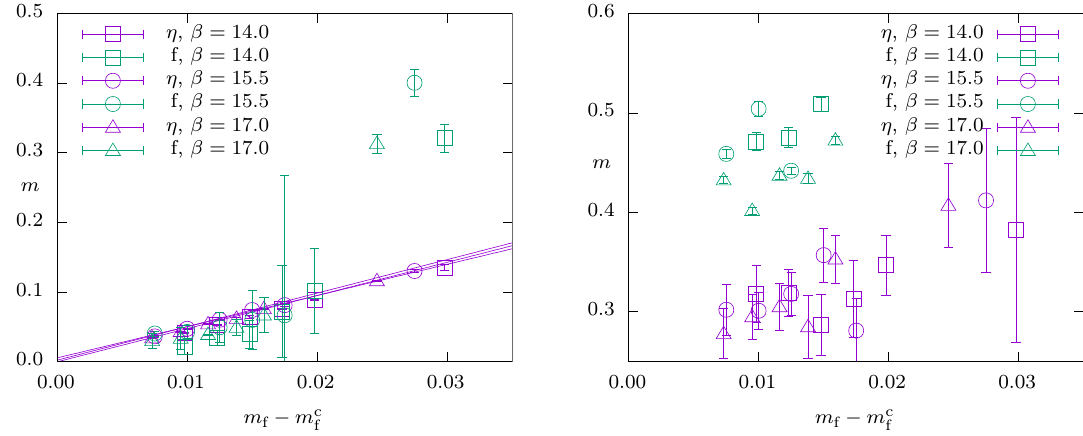
Figure 11. Ground (left) and excited (right) state masses of the (cid:17) - and f-meson as function of the pion mass squared for (cid:12) = 14, 15 : 5 and 17. For the (cid:17) ground states we show linear (cid:12)ts. these results with the e(cid:11)ective mass extracted from the corresponding correlation